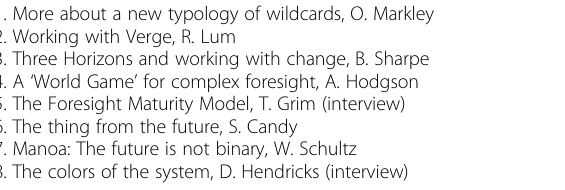
Table 3 Chapters from The APF Methods